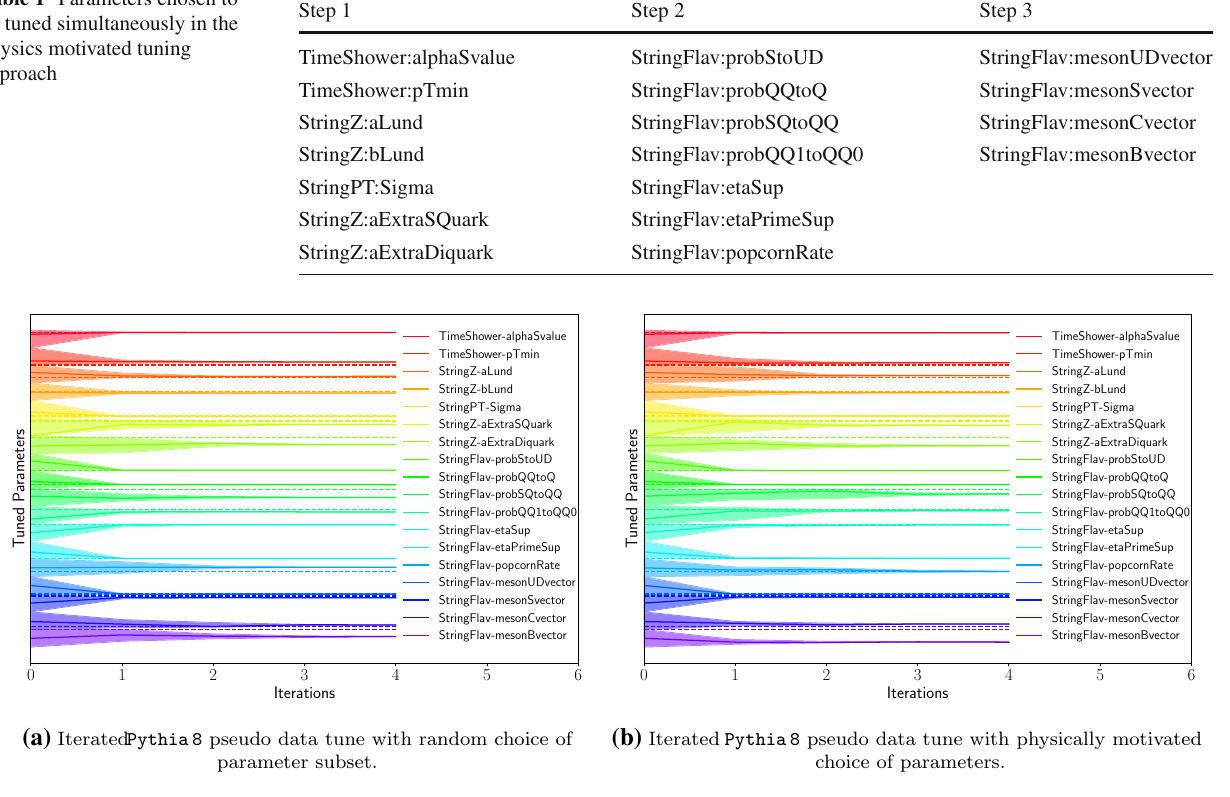
Table 1 Parameters chosen to be tuned simultaneously in the physics motivated tuning approach